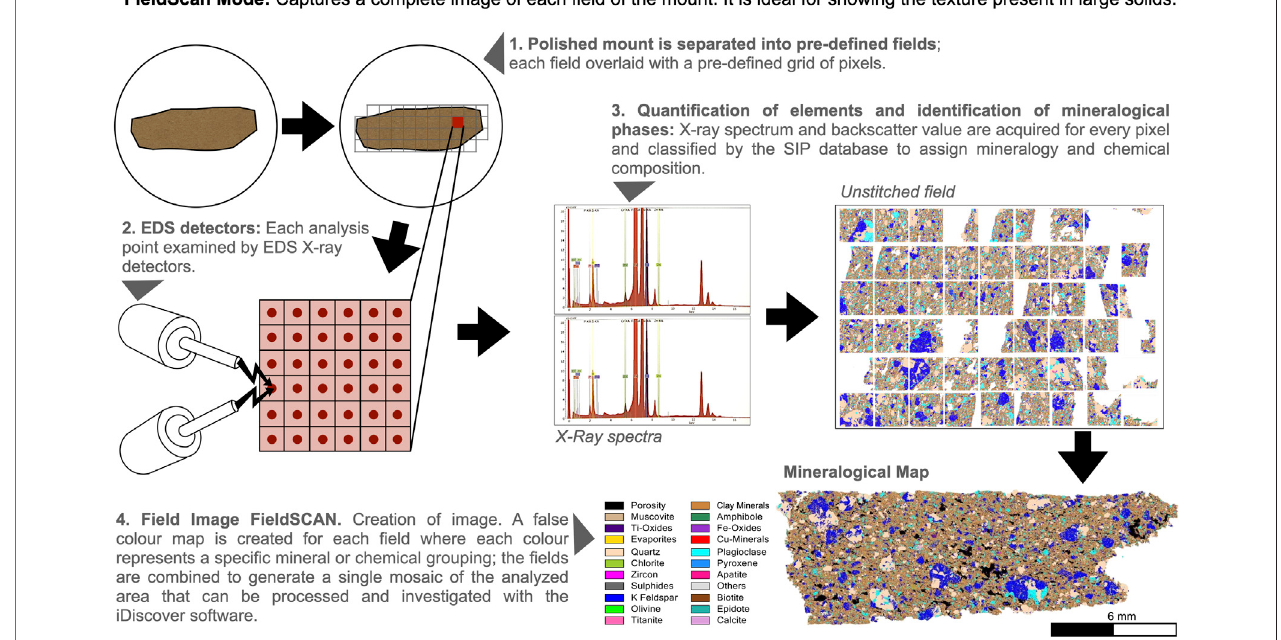
FIGURE 4 | Schematic illustration of the FieldScan measurement mode for data reduction.